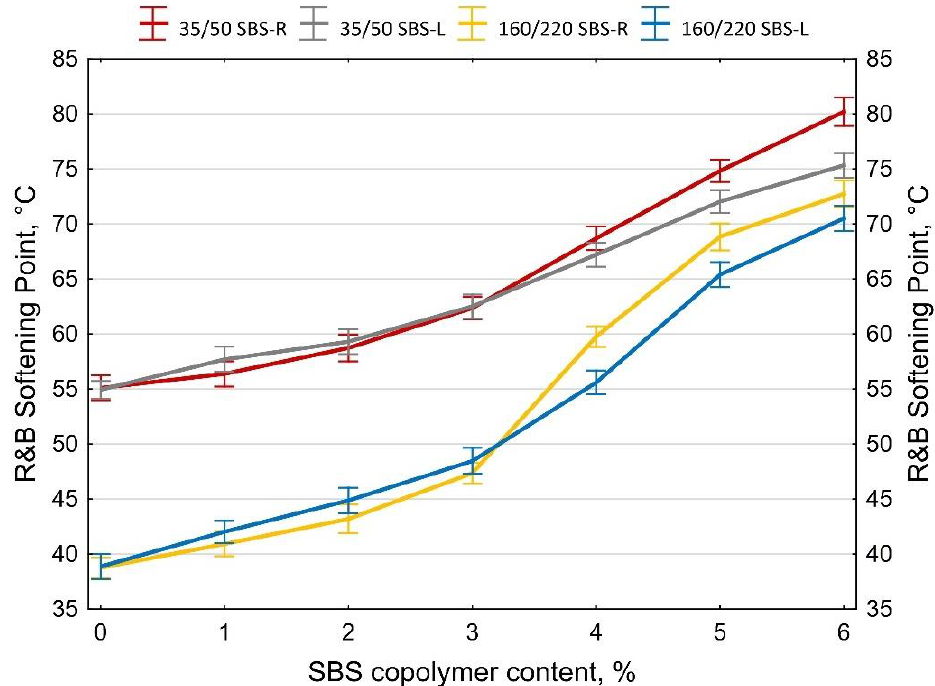
Figure 7. T R&B softening point of SBS-modified bitumens, error bars show a 95% confidence interval for the mean.